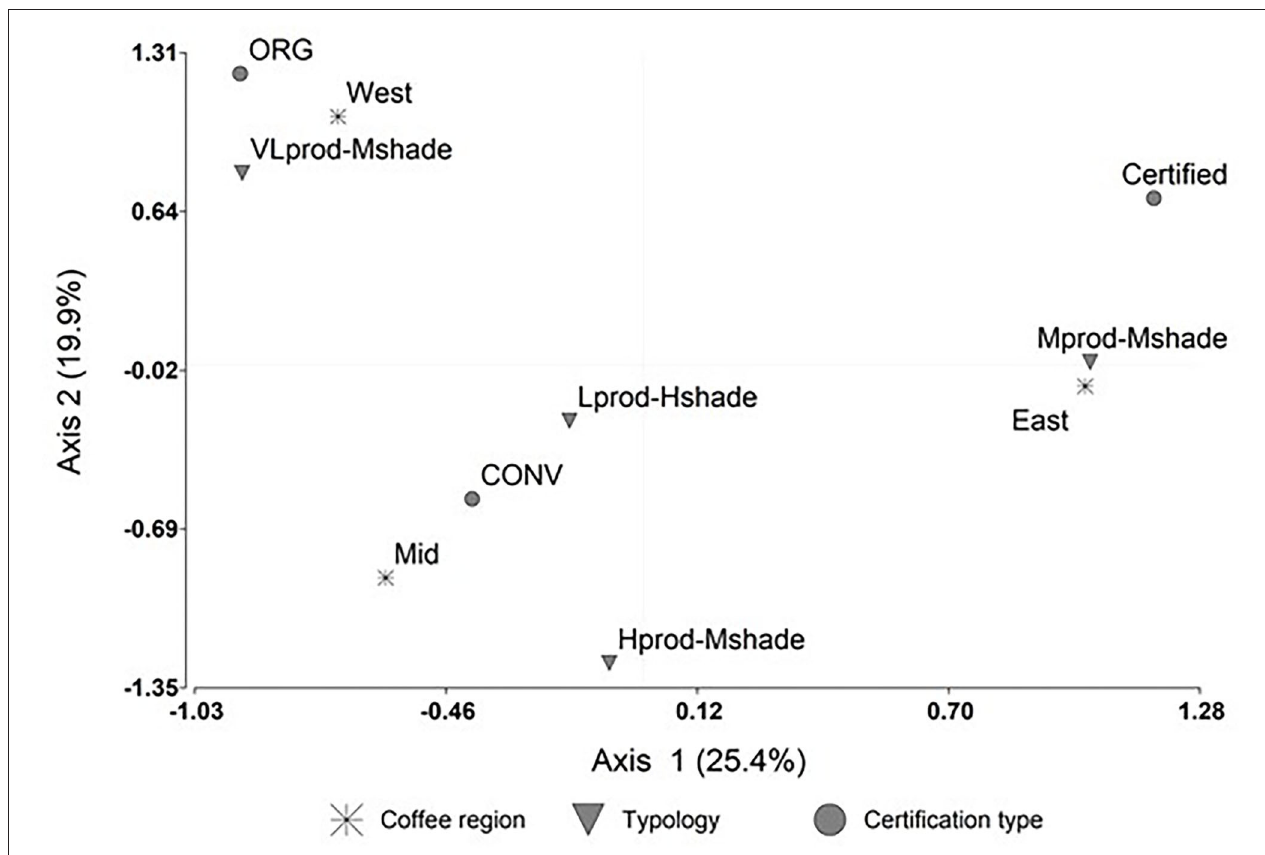
FIGURE 3 | Degree of association between coffee plantation typologies (key to codes see Table 2 ), regions (see Table 1 ) and certification type in Guatemala using a biplot from multiple correspondence analysis. Key to typologies: Hp-Ms, High productivity, Medium shade; Mp-Ms, Medium productivity, Medium shade; Lp-Hs,